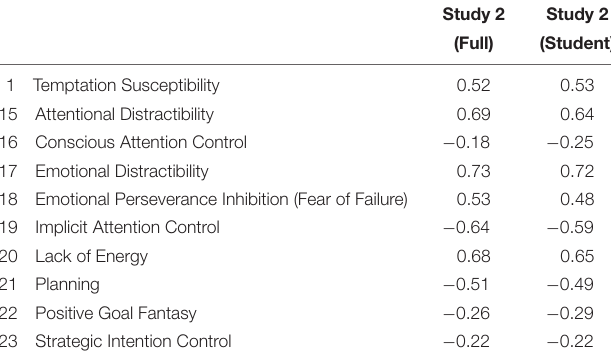
TABLE 5 | Bivariate correlations between procrastination and VCI scales as well as Temptation